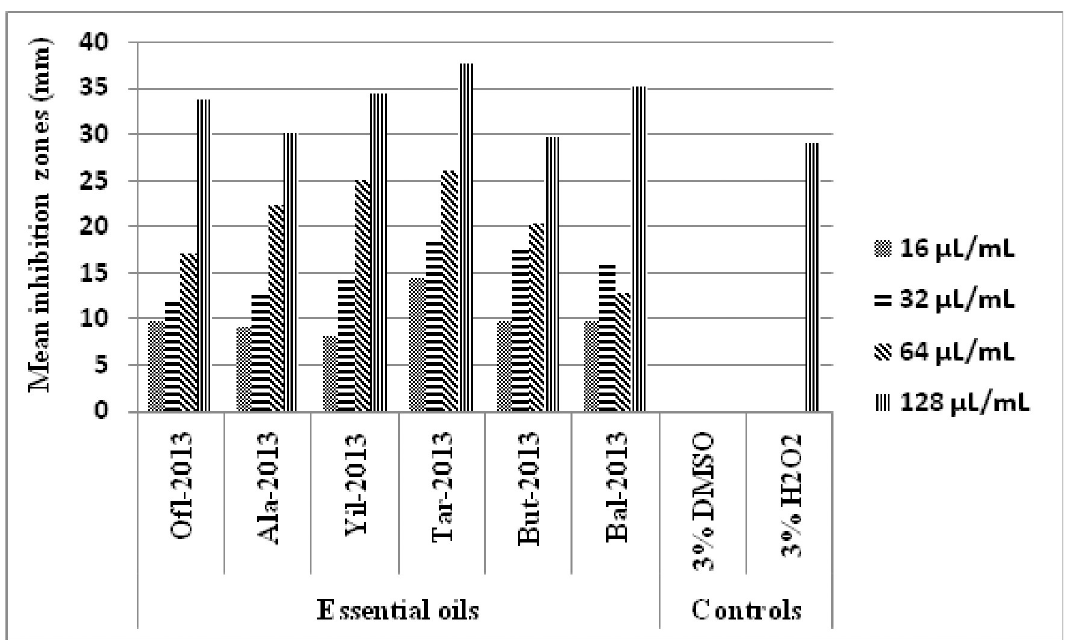
Fig 2. Inhibition of S . mutans by EOs from six localities with doses ranging from 16 μ l/mL to 128 μ l/mL in comparison with the negative and positive